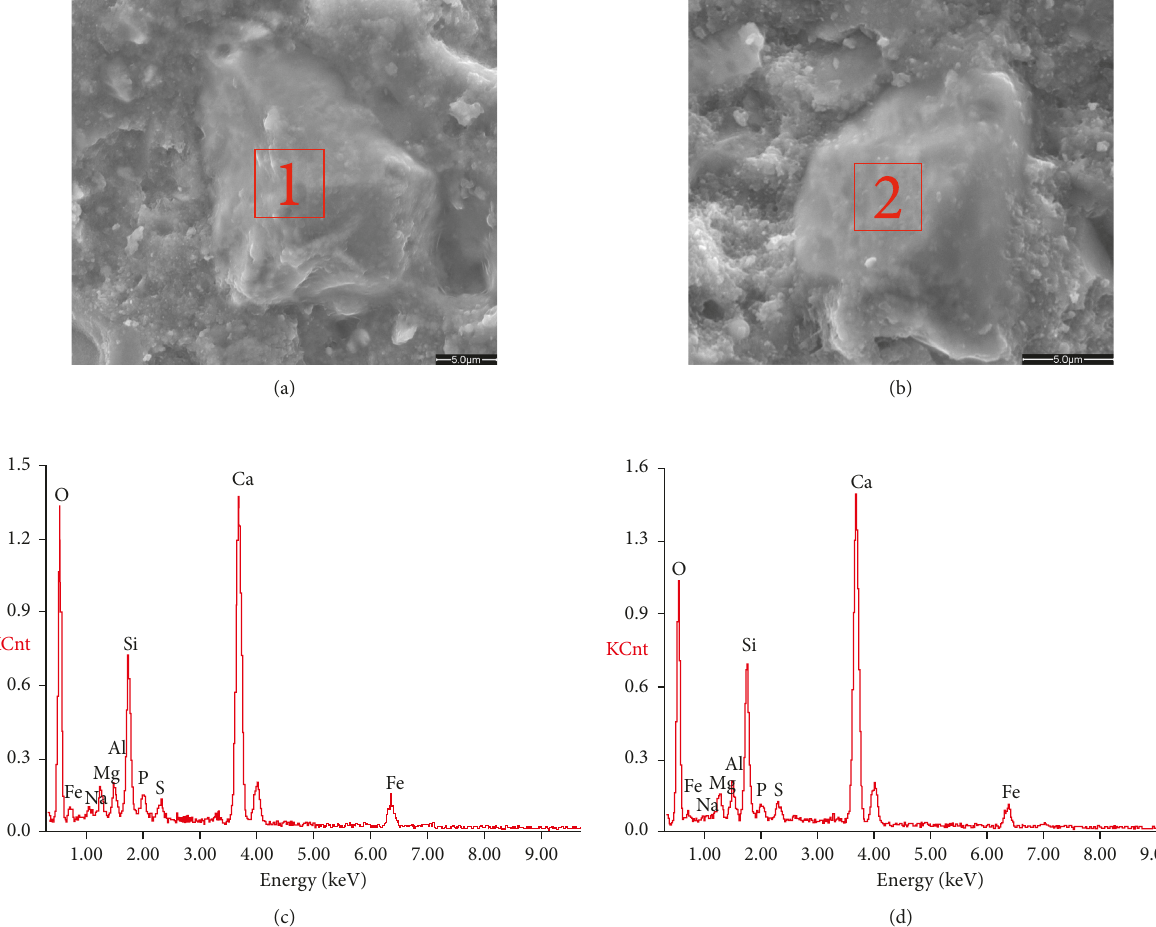
Figure 6: (a) SEM morphology of hardened paste PS3 at 28d. (b) SEM morphology of hardened paste PS4 at 28 d. (c) EDX spectrum of position 1. (d) EDX spectrum of position